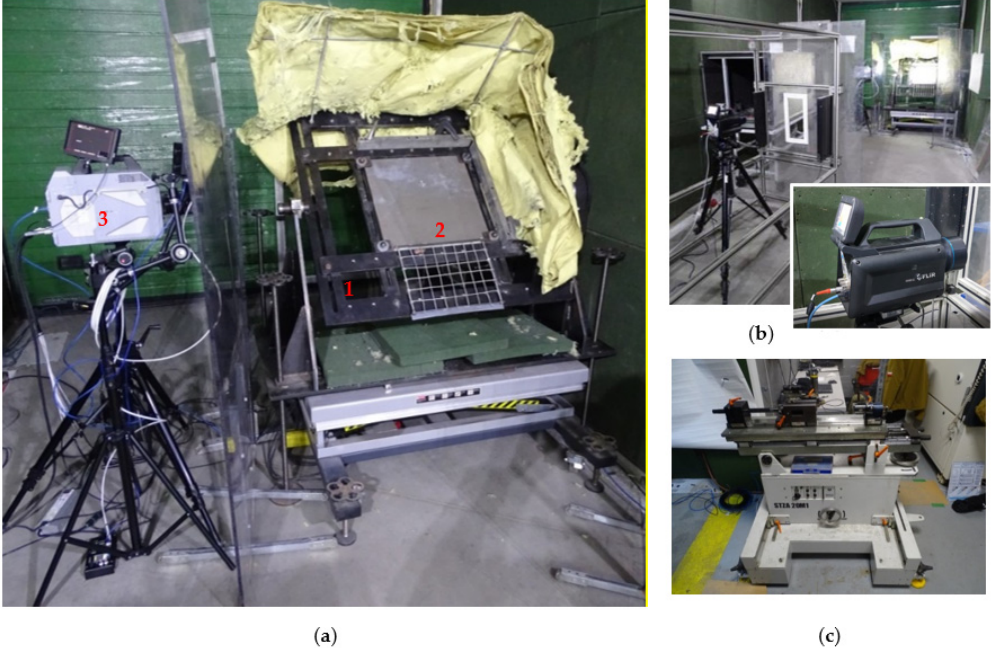
Figure 4. Laboratory stand for measuring temperature of ricocheting projectiles: ( a ) 1—mounting stand, 2—500 × 500 × 10 mm Armox 600 armour plate, 3—Photron Fastcam SA-Z 2100 K high-speed camera, ( b ) FLIR X6580sc thermal camera, ( c ) ballistic mount with 5.56 × 45 mm ballistic